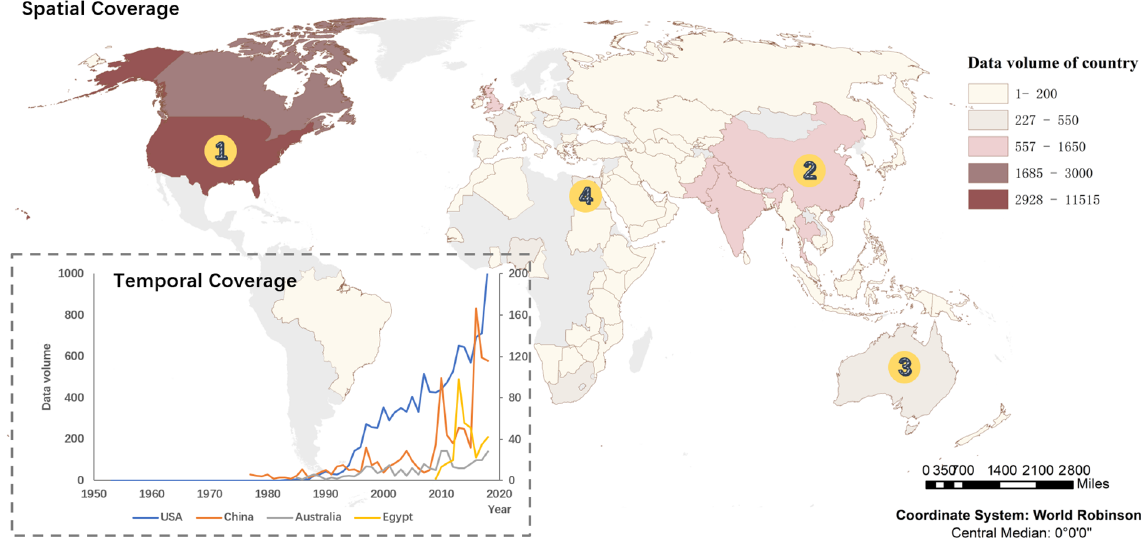
Figure 4. Spatial coverage and temporal coverage on a country scale (1 – USA; 2 – China; 3 – Australia; 4 – Egypt).